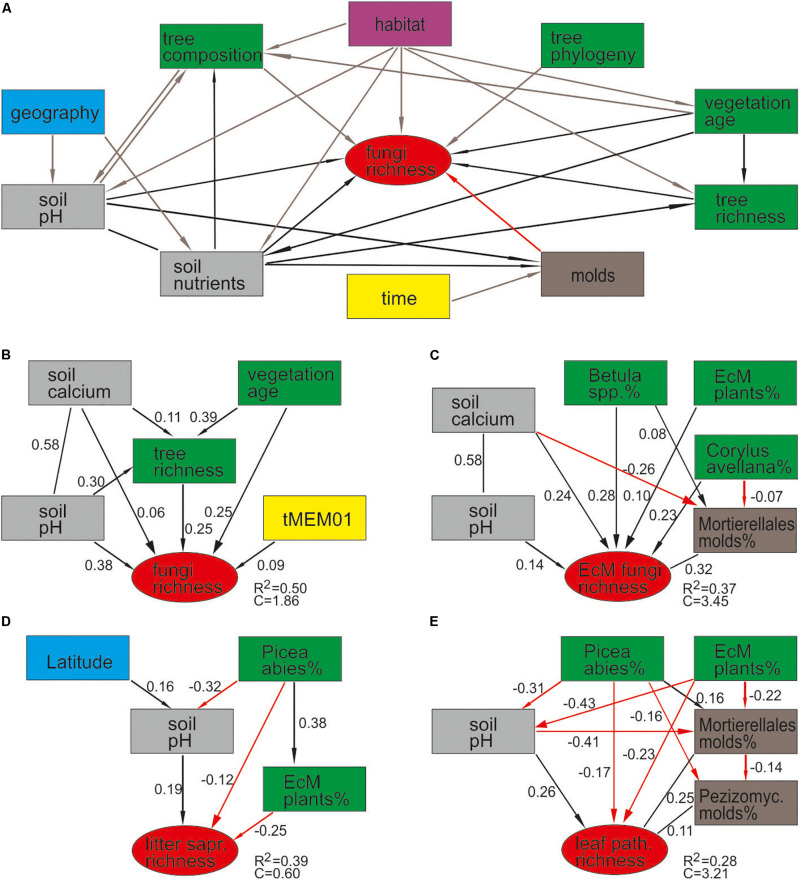
Structural equation models for predicting fungal richness: (A)
a priori model based on expected relationships; AICc-based best models for (B) all fungi, (C) ectomycorrhizal fungi, (D) litter saprotrophs, and (E) leaf pathogens.